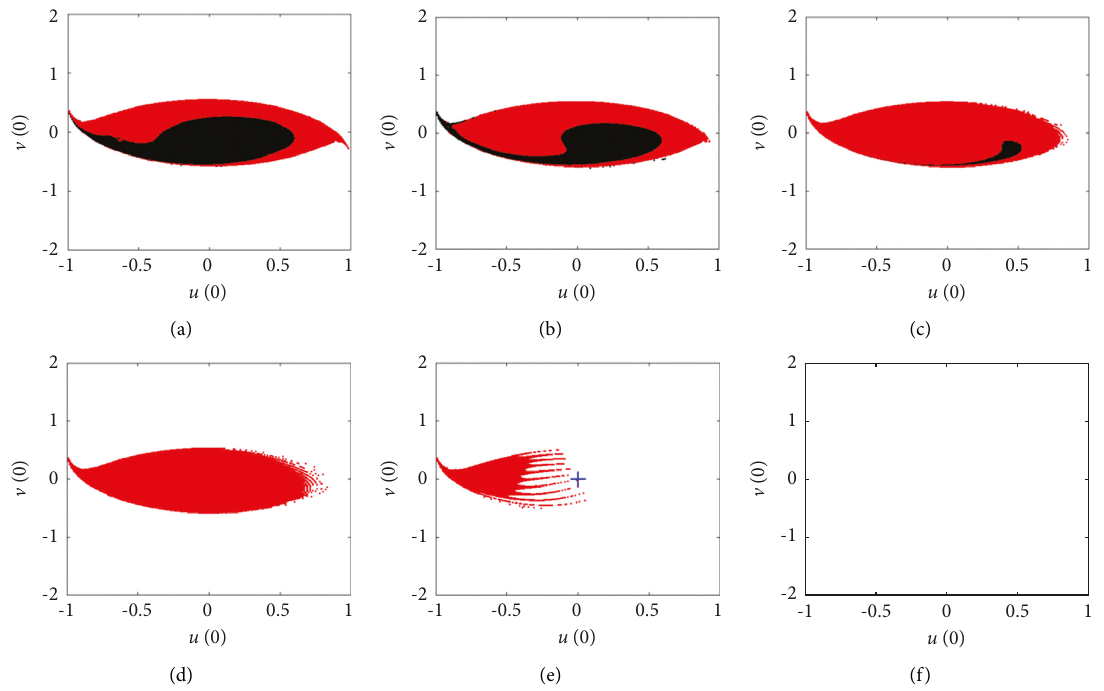
Figure 8: Evolution of basins of attraction of system (2) with the increase of f f � 0 . 38. (d) f 0